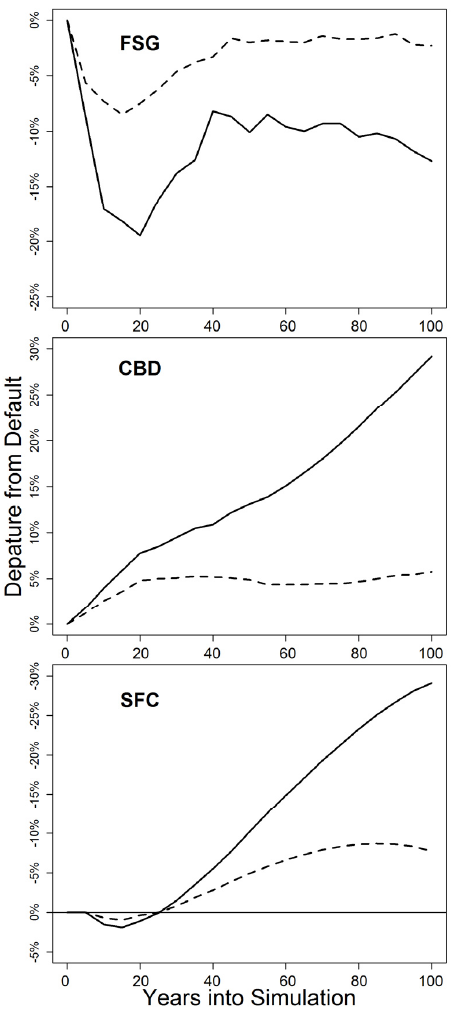
Figure 6. Average departure across all simulations of the FSG ( Top ), CBD ( Middle ), and SFC ( Bottom ) when calculated for simulations with the 0.5 (dashed line) and 0.0 (solid line) FVS CRNMULT settings as compared to the Default.